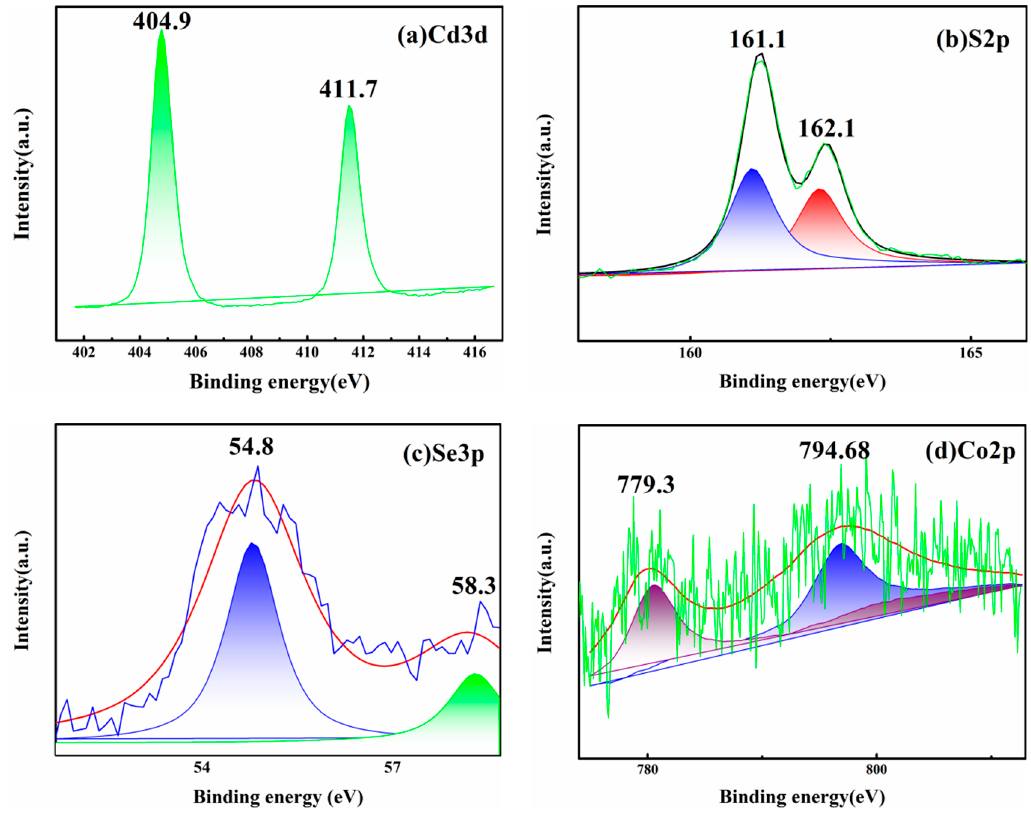
Figure 4. XPS pattern of 30% CoSe 2 /CdS: ( a ) Cd3d; ( b ) S2p; ( c ) Se3p; and ( d ) Co2p.